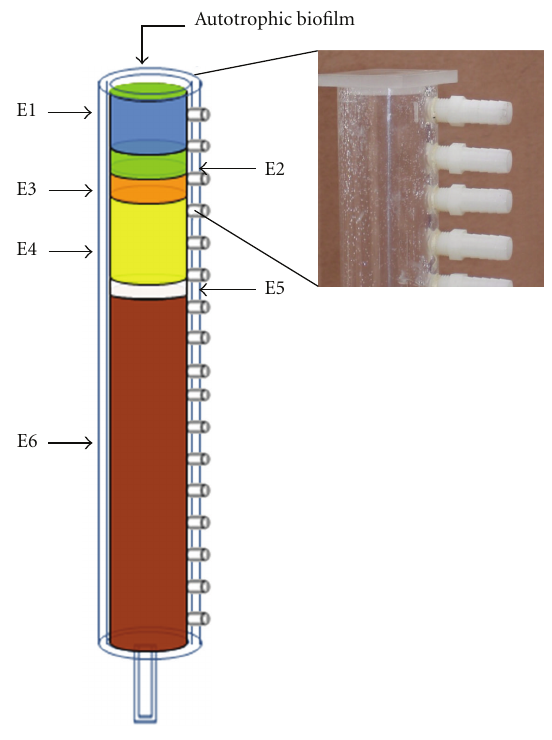
Figure 3: Columns constructed for the bioassays.